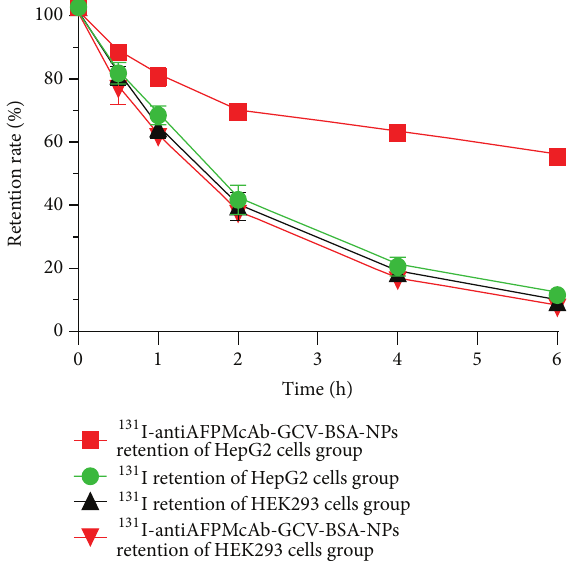
Figure 3: Uptake curves of 131 I and 131 I-antiAFP-GCV-BSA-NPs in HepG2 cells and HEK293 cells. The intake ratios of 131 I- antiAFPMcAb-GCV-BSA-NPs in HepG2 cells group are far higher than those of 131 I in HepG2 cells group, 131 I-antiAFPMcAb-GCV- BSA-NPs in HEK293 cells group, and 131 I in HEK293 cells group.